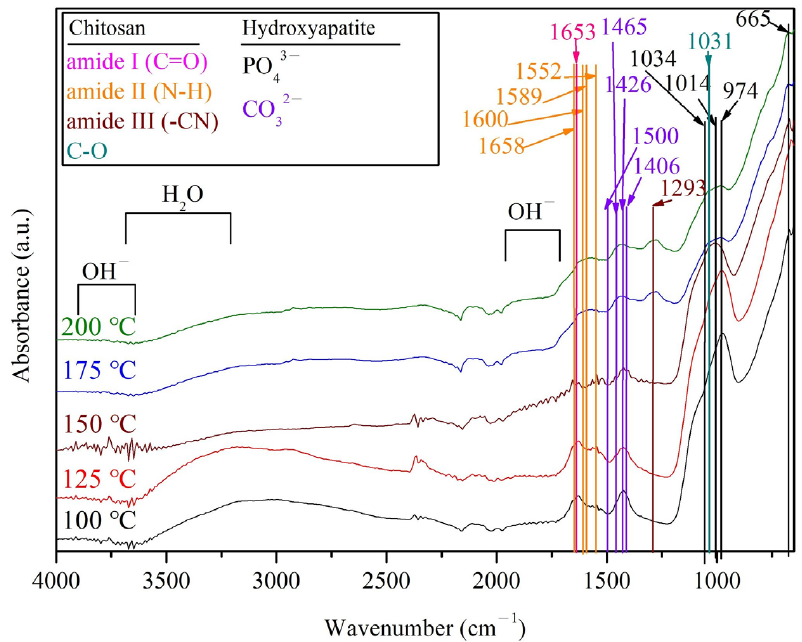
Figure 4. FTIR spectra of HA/CS composite coatings on Ti–25Nb–8Sn alloy after alkali treatment and hydrothermal reaction at various temperatures.